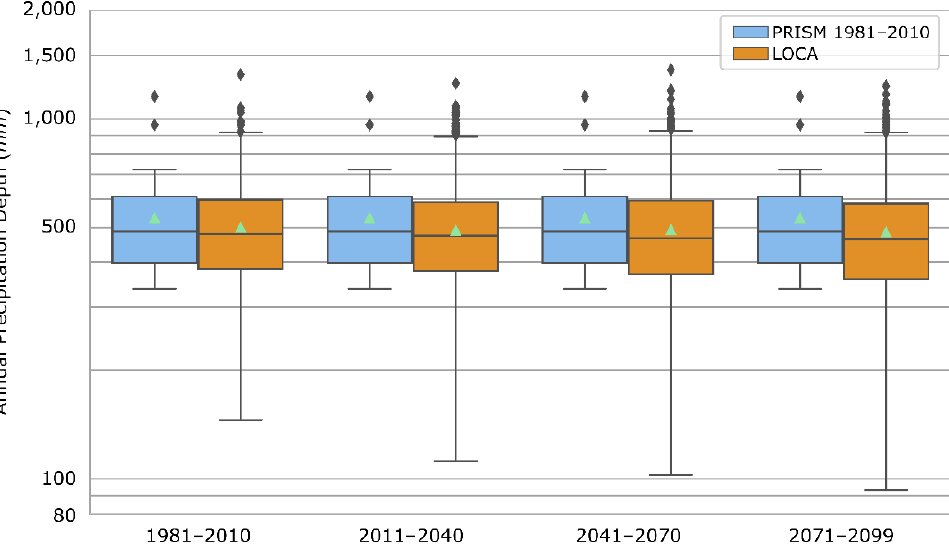
Figure 6. Observed, empirical distributions of site watershed, annual precipitation depth. The box plot format provides the interquartile range (1/4 to 3/4 quantiles) in the shaded “box” for the sample. The median is the horizontal line within the shaded, interquartile range, and the mean is identified with the green triangle. Whiskers extend out to 1.5 times the interquartile range from the lower and upper quartile. Extreme values are shown as individual diamonds. The median annual precipitation depth and interquartile range are almost identical across the four analysis intervals in the “LOCA Archive.”